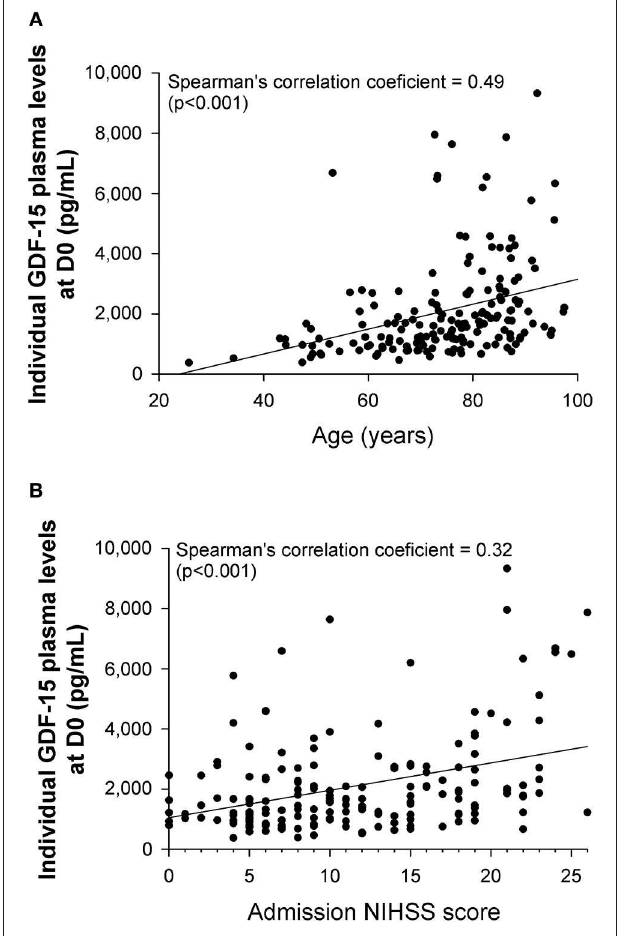
FIGURE 3 | Median GDF-15 plasma levels at D0 ( n = 173), D1 ( n = 163), D3 ( n = 124), and D7 ( n = 45) according to vital status at 3